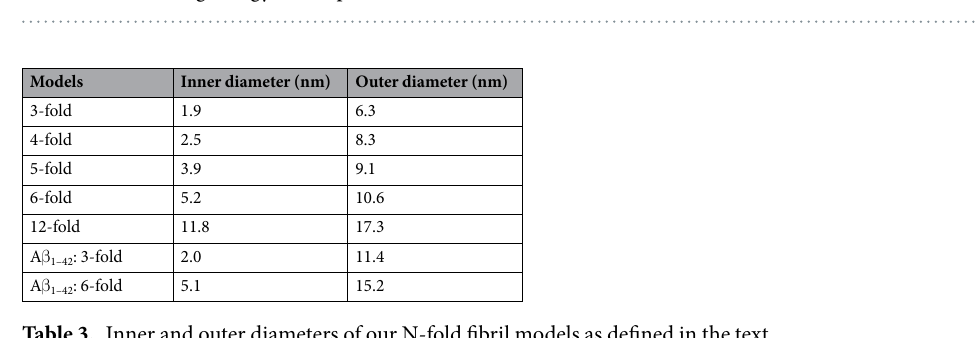
Table 3. Inner and outer diameters of our N-fold fibril models as defined in the